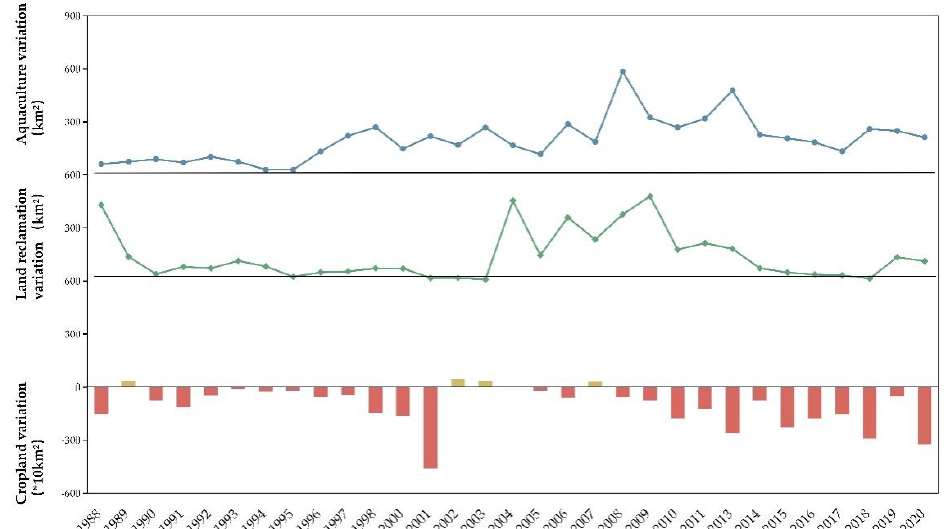
Figure 4. Analysis of the change process of a typical feature area in Bohai rim coastal area from 1987 to 2020.